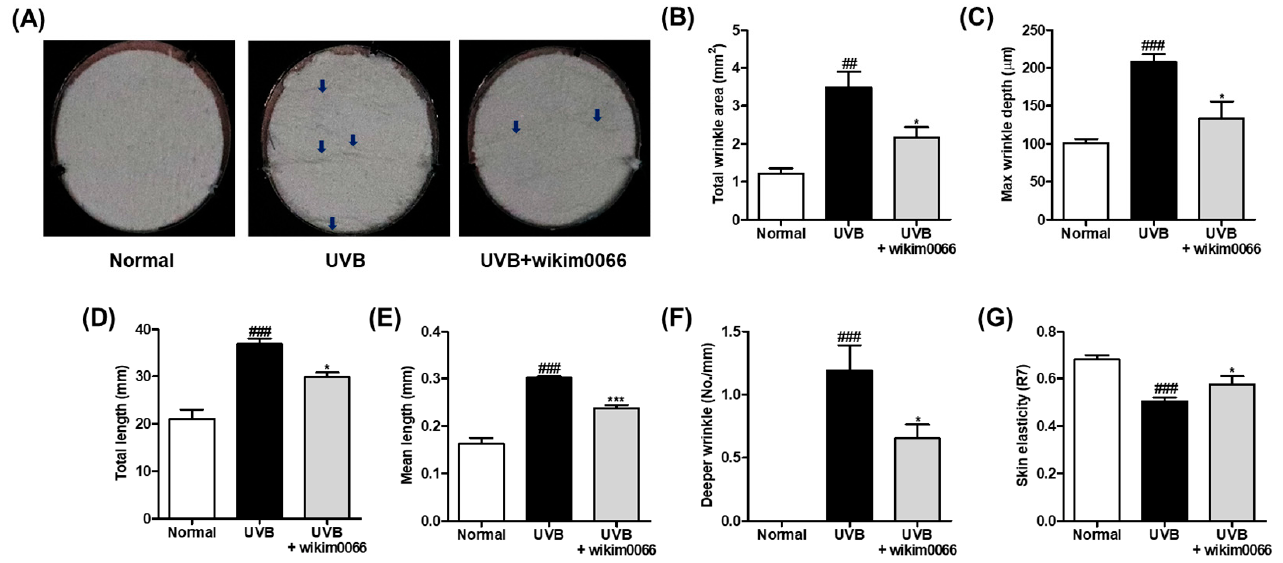
Figure 5. Effect of wikim0066 administration on wrinkle-related parameters in UVB-irradiated hairless mice. Skin replica ( A ), total wrinkle area ( B ), max wrinkle depth ( C ), total length ( D ), mean length ( E ), and deeper wrinkle ( F ) were measured on dorsal skin replica. The blue arrows indicate the wrinkled area. Skin elasticity ( G ) was measured using Cutometer. HR-1 hairless mice were orally administrated wikim0066 (1 × 10 9 CFU/head) three times a week for 12 weeks with UVB irradiation. Results are expressed as mean ± SEM ( n = 6). ## p < 0.01, ### p < 0.001 vs. normal, and * p < 0.05, *** p < 0.001 vs. UVB-control.